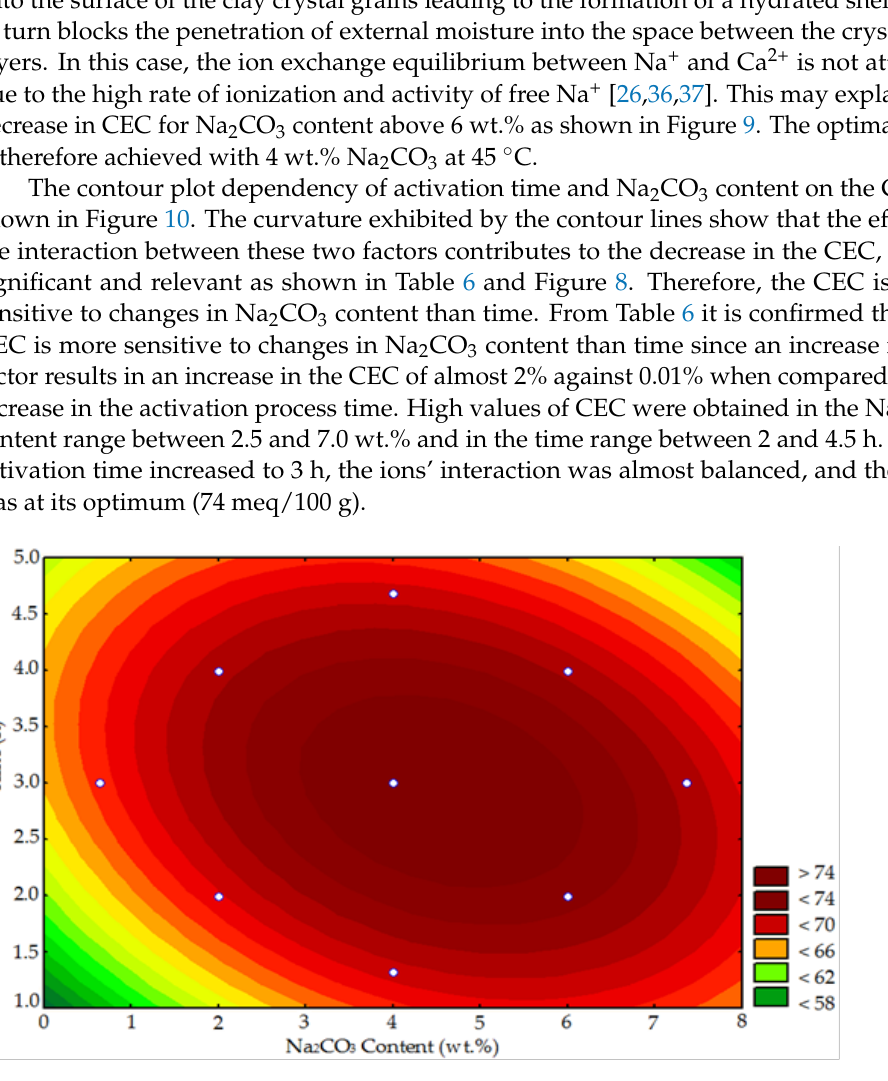
Figure 10. The contour plot dependency of stirring time and Na 2 CO 3 concentration on CEC. Note: the white points in the image represent the lower and upper limits and the central point of the factors (time and Na 2 CO 3 concentration), including their critical points leading to a minimum and maximum CEC.